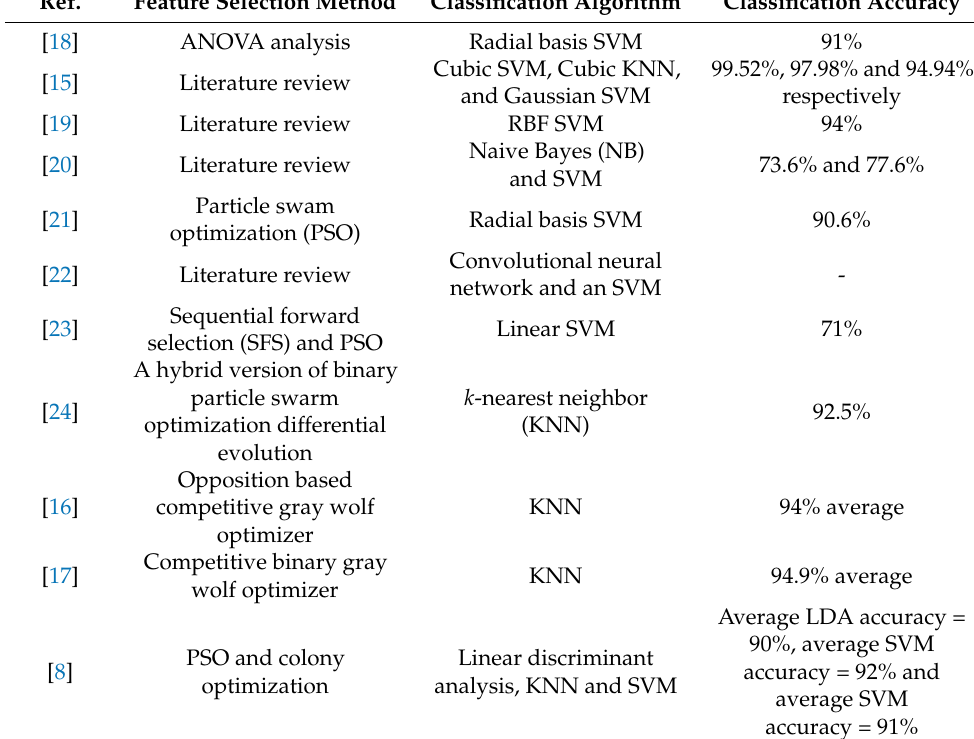
Table 1. Comparative table of classification algorithms, selection methods, and classification accuracy.